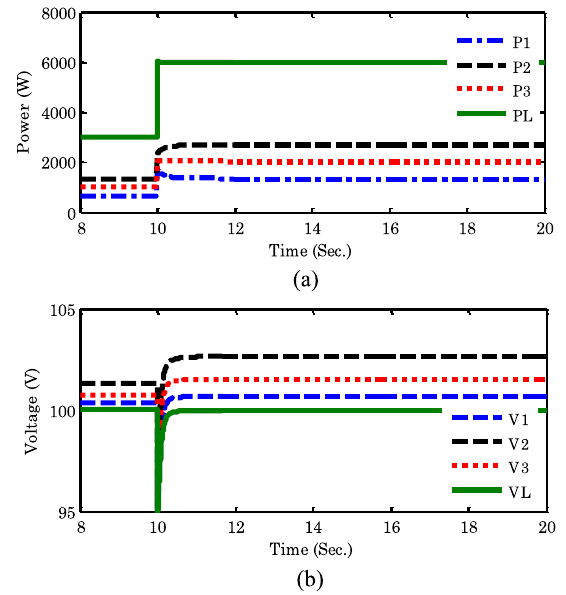
Fig. 6 Performance of the proposed secondary control based on LBC, ( a ) Output power of the converters and load power, ( b ) Output voltages of the converters and load voltage